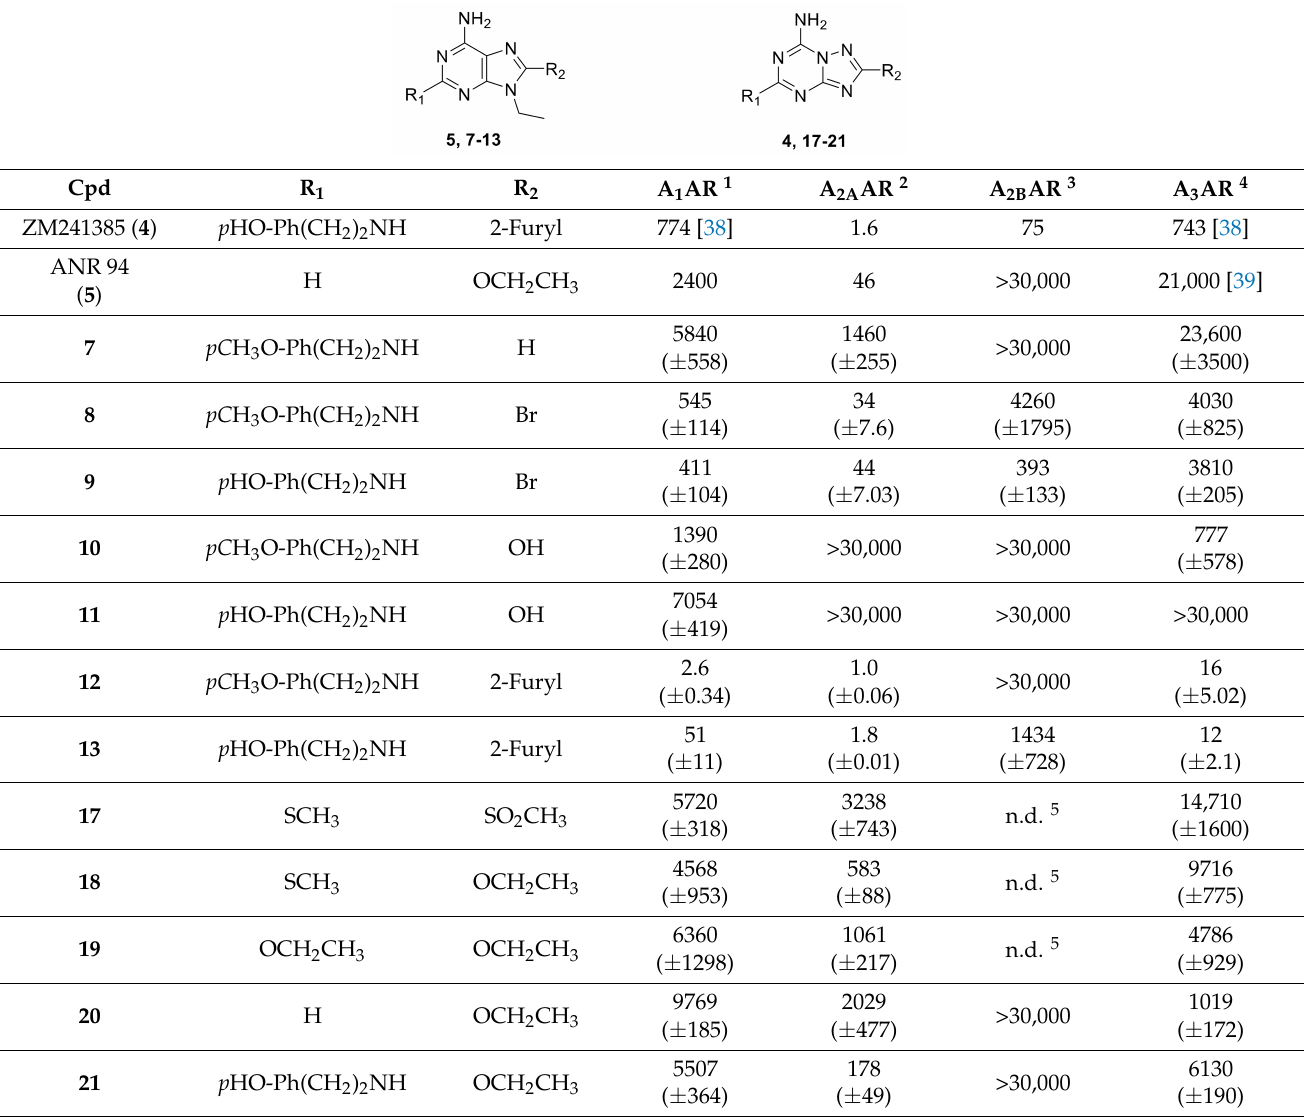
Table 1. Binding data at A 1 , A 2A , and A 3 ARs or adenylate cyclase activity at A 2B AR of